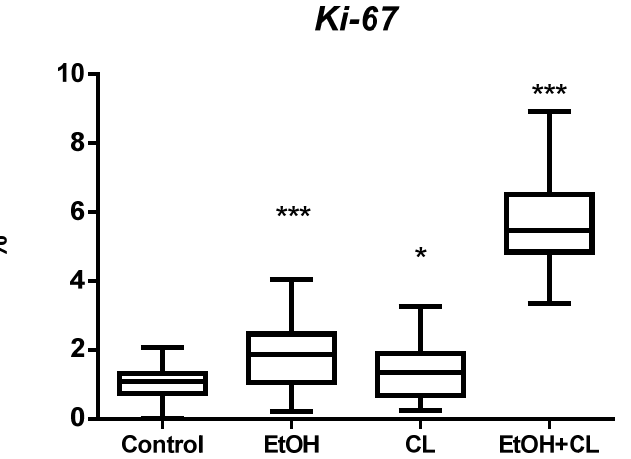
Figure 3. Levels of Ki-67 expression in hepatocytes of rats. * ( p ≤ 0.05); *** ( p ≤ 0.0005)—in compari- son with the parameters of animals of the control group.